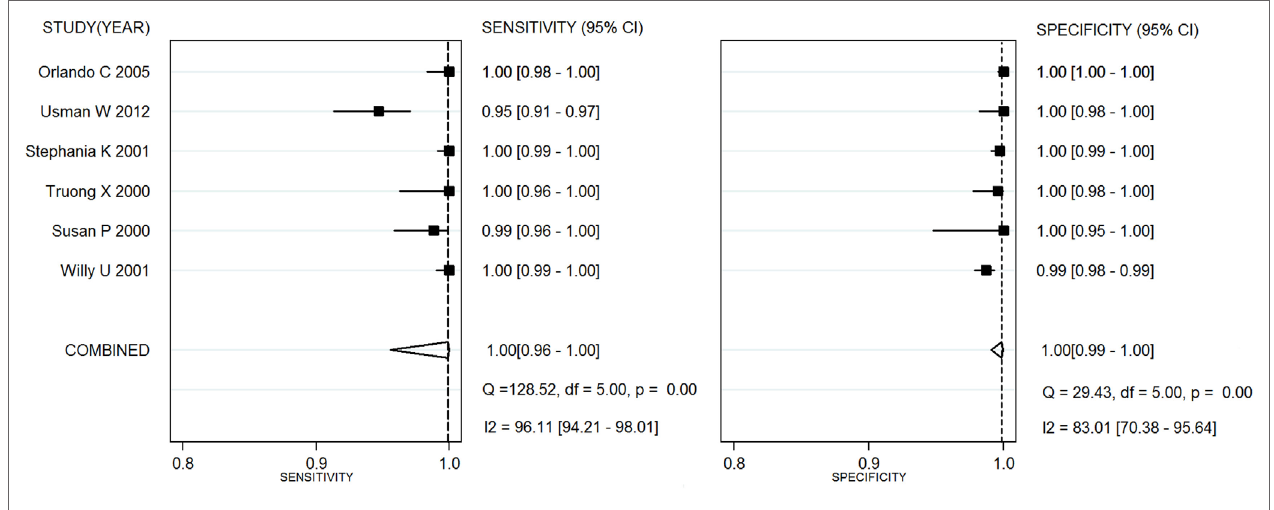
FigURe 2 | Forest plots for rapid test assay Capillus HIV-1/HIV-2 ® .